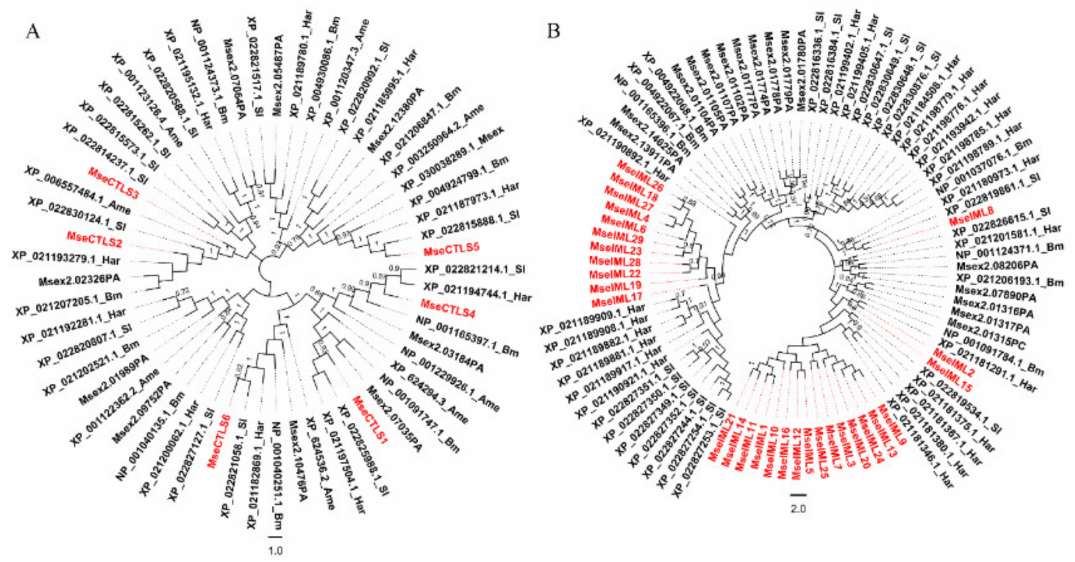
Figure 5. Phylogenetic trees of CTL-S and IML. Protein sequences of 57 CTL-S ( A ) and 90 IML ( B ) were aligned by MUSCLE (https://www.ebi.ac.uk/Tools/msa/muscle/) (accessed on 10 May 2021). The neighbor-joining tree was constructed in MEGA X. The percentage (>70%) of replicate trees in which the associated taxa clustered together in the bootstrap test (1000 replicates) were shown next to the branches as decimals. The evolutionary distances were computed using the p-distance method and are in the units of the number of amino acid differences per site. All ambiguous positions were removed for each sequence pair (pairwise deletion option). M. separata CTLs are shown in red. Msex: Manduca sexta ; Bm: Bombyx mori ; Ame: Apis mellifera ; Sl: Spodoptera litura ; Har: Helicoverpa armigera